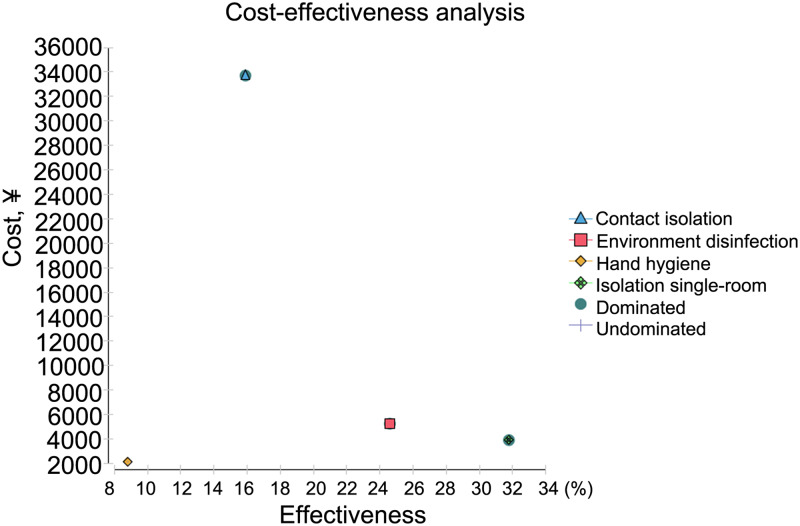
Cost-effectiveness analysis of the four intervention strategies.